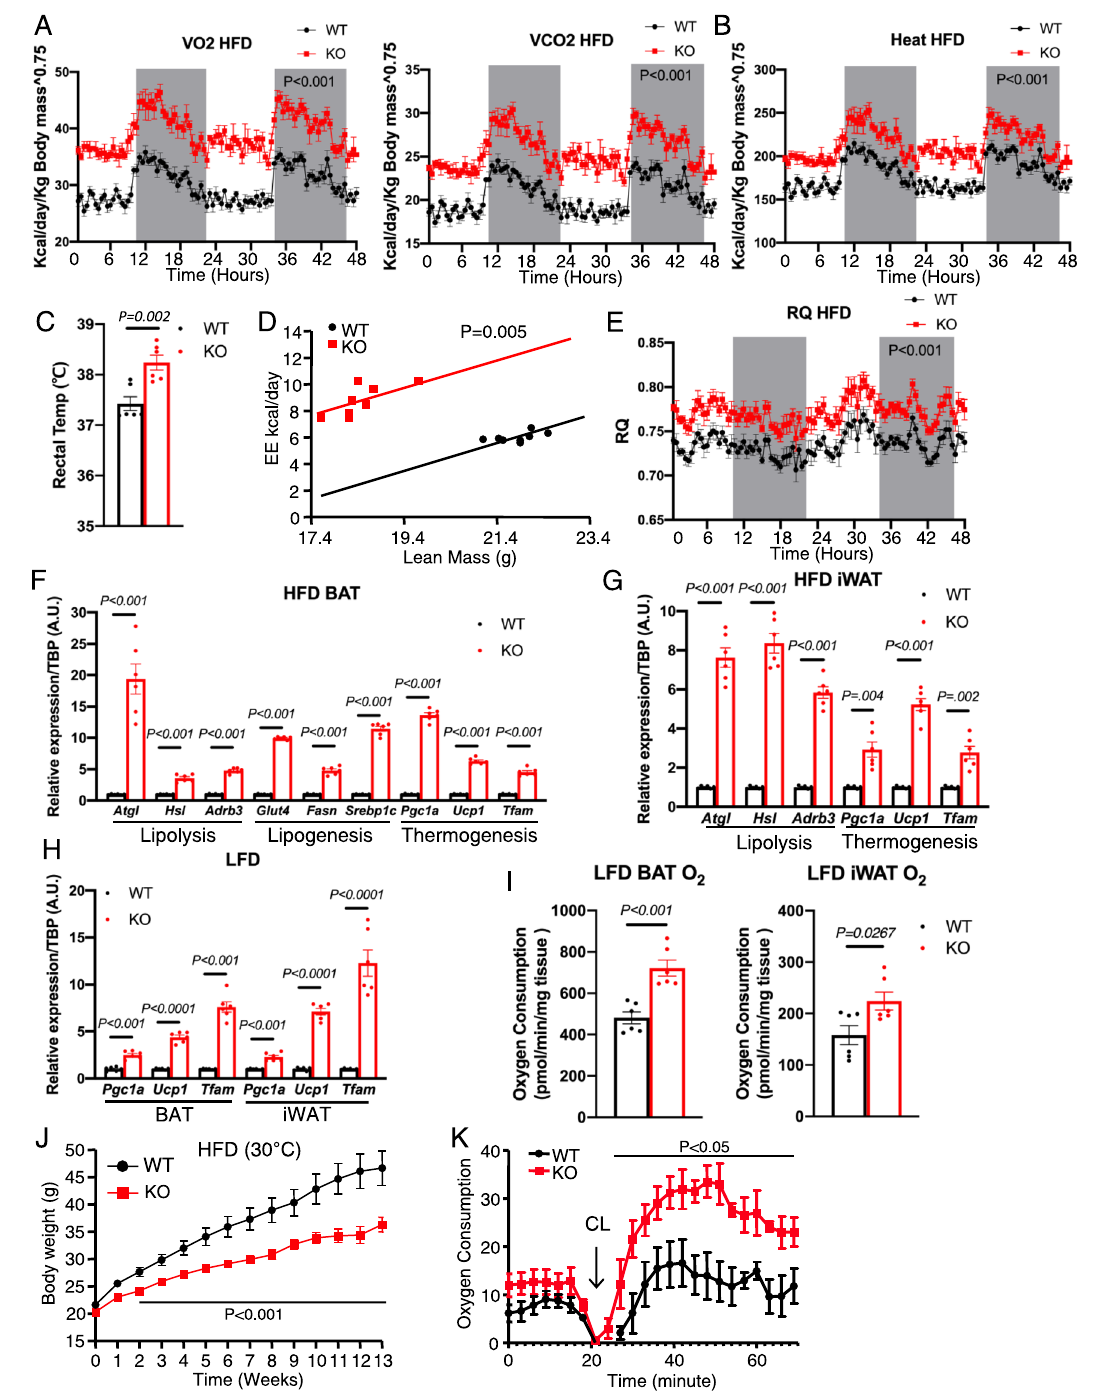
Fig. 4 | EMC10 ablation promotes adipose tissue oxygen consumption and whole-body energyexpenditure. A Oxygen consumption (VO2)(left) and carbon dioxide production (VCO2) (right), B Heat production analyzed by indirect calorimetryfor48hinmaleWT(blackcircle)orKO(redsquare)miceafterfedwith 12-wks of HFD ( n =8 per group). C Rectal temperature measured for male WT (black)andKO(red)micefedHFDatroomtemperature( n =8pergroup). D Energy expenditure analyzed with ANCOVA using lean mass as covariate for WT (black circle) or KO (red square) mice ( n =8 per group). E Respiratory exchange ratio (RER) analyzed by indirect calorimetry in male WT (black circle) and KO (red square)micefedwithHFD( n =6pergroup). F Atgl,Hsl,Adrb3,Glut4,Fasn,Srebp1c, Pgc1a, Ucp1 , and Tfam mRNA in BAT from male WT (balck) or KO (red) mice after fed with 12-wks of HFD ( n =6 per group). G Atgl, Hsl, Adrb3, Pgc1a, Ucp1 , and Tfam